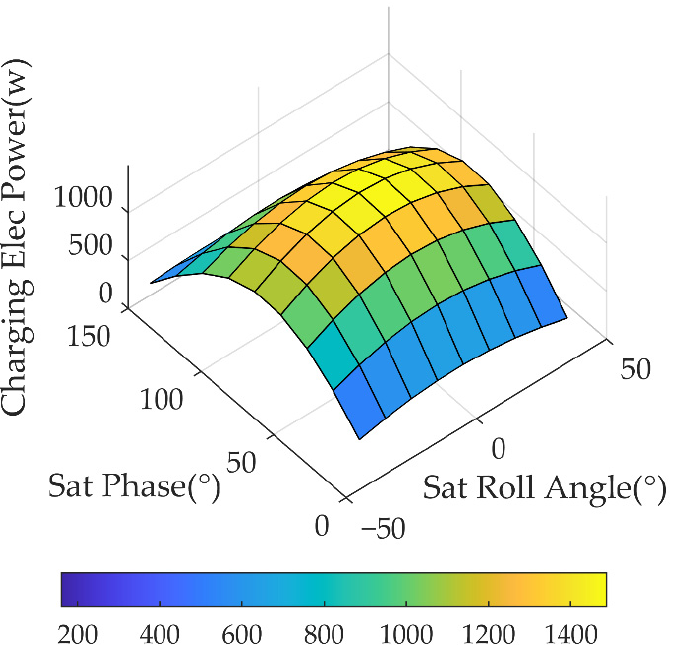
Figure 5. Influence diagram of the satellite phases and attitudes on charging power.